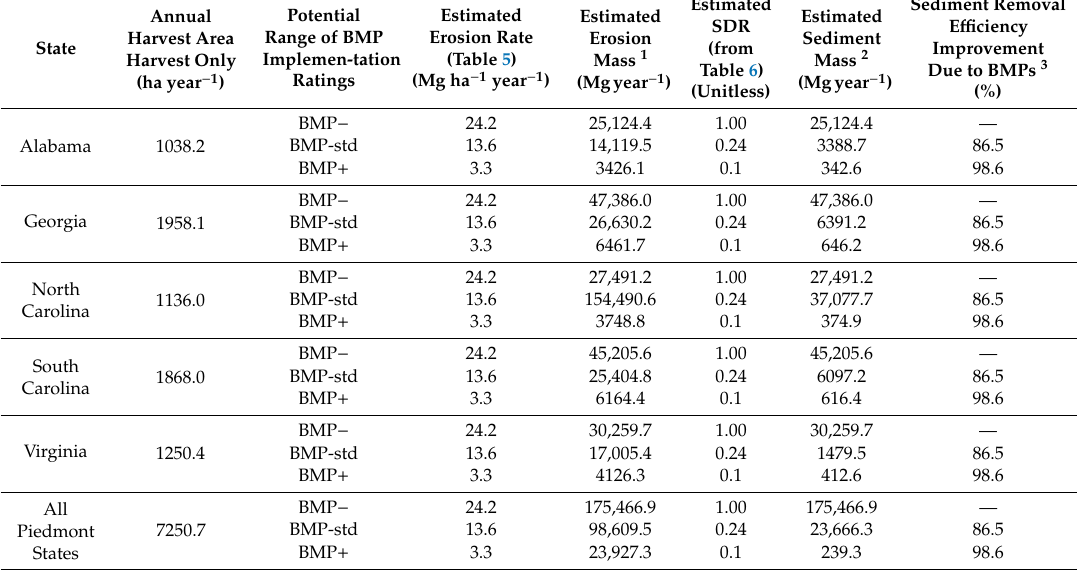
Table 10. Estimated erosion rates, erosion, masses, sediment delivery, and sediment removal e ffi ciencies due to BMP implementation levels by state for skid trails.